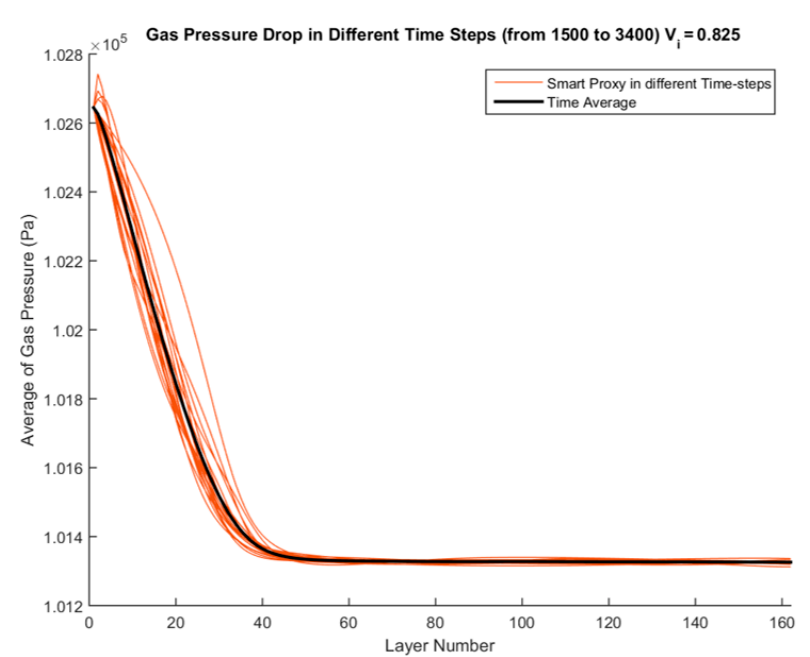
Figure 49. Spatial average profile of smart proxy results for gas pressure (Pa) for time steps 1500 to 3400 at blind test condition of V in = 0.825 m/s.